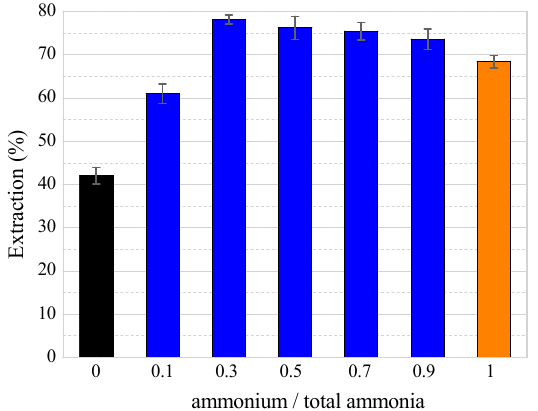
Figure 7. The effect of the ammonia/ammonium ratio on the zinc extraction. (Note: [NH 4 ], [NH 3 ], and [NH 3 ] T represent the concentration of ammonia, the concentration of ammonium, and the total ammonia concentrations of ammonia and ammonium, respectively.)